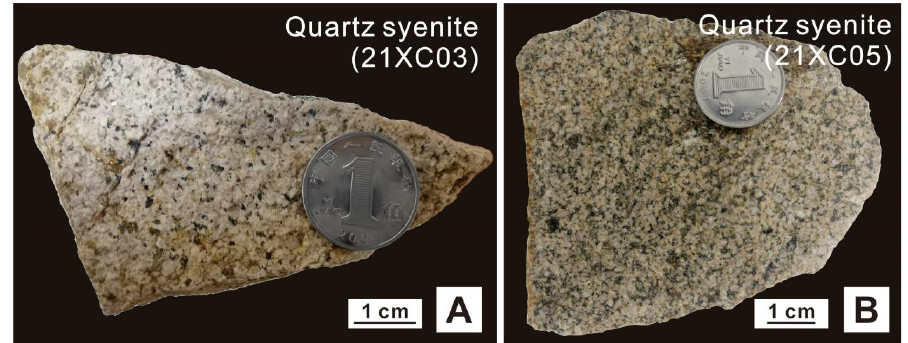
Figure 2. Hand specimen photographs of the alkaline rocks. ( A ) Quartz syenite (21XC03); ( B ) Quartz syenite (21XC05).